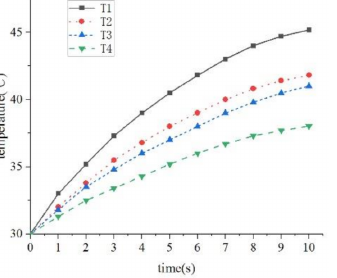
Figure 13. Maximum surface temperature varying with